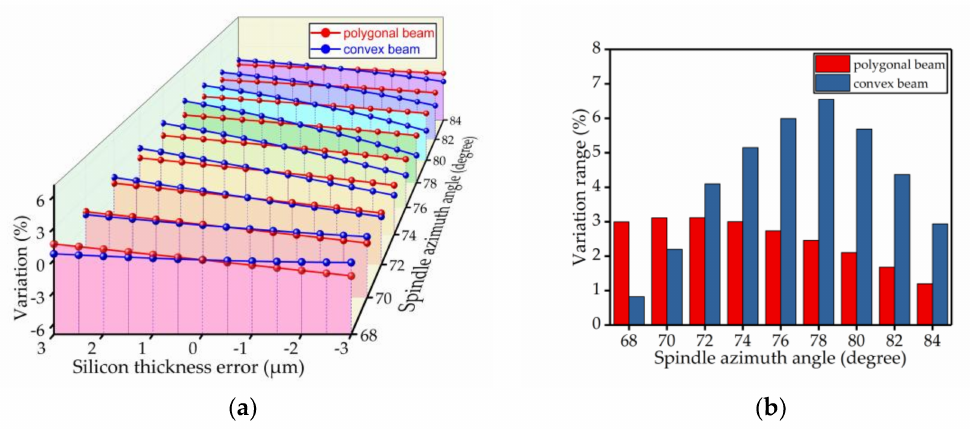
Figure 10. The influence of the silicon thickness error on the spindle azimuth angle of the polygonal cross-section beam and convex cross-section beam; ( a ) shows the relationship between spindle azimuth angle variation and silicon thickness error; ( b ) shows the range of variation—the value is the difference between the maximum and minimum values of each